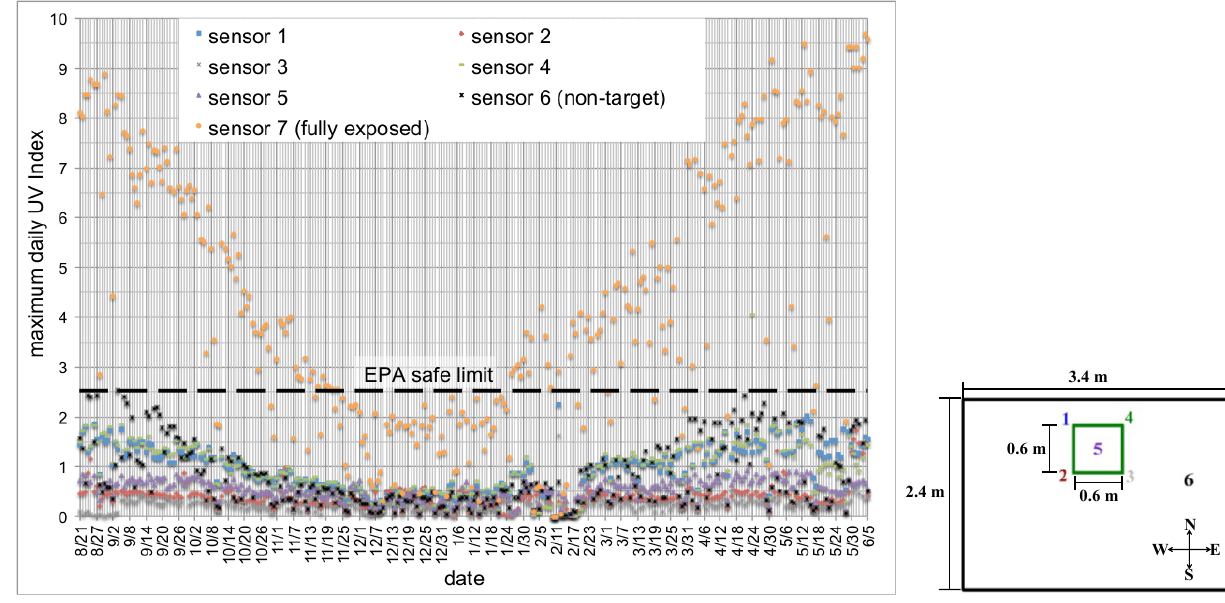
Figure 6. Maximum UV Index values recorded by the sensors (see plan view for sensor locations) located in (sensors 1–5) and outside the target area (sensors 6 and 7) for the period 21st August 2013–5th June